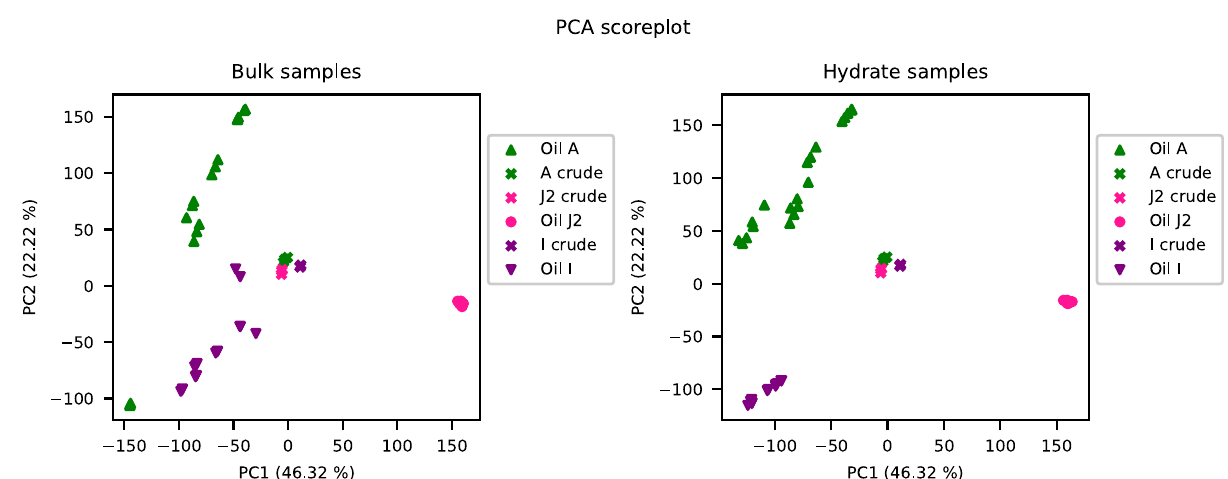
Fig 2. PCA scoreplots with samples from the bulk phase shown in the left plot and samples from the hydrate phase shown in the right plot. Samples are coloured according to which crude oil they originated from and the crude oils have the symbol x.